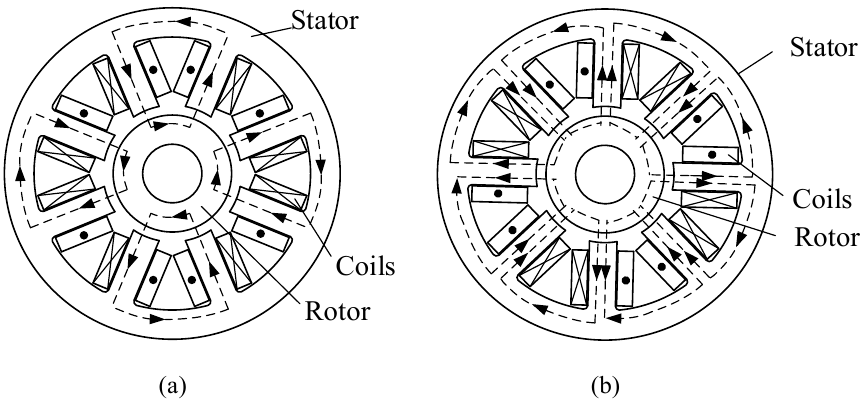
Figure 6. The 8-pole RMB structure. ( a ) NNSS structure of magnetic pole distribution. ( b ) NSNS structure of magnetic pole distribution.